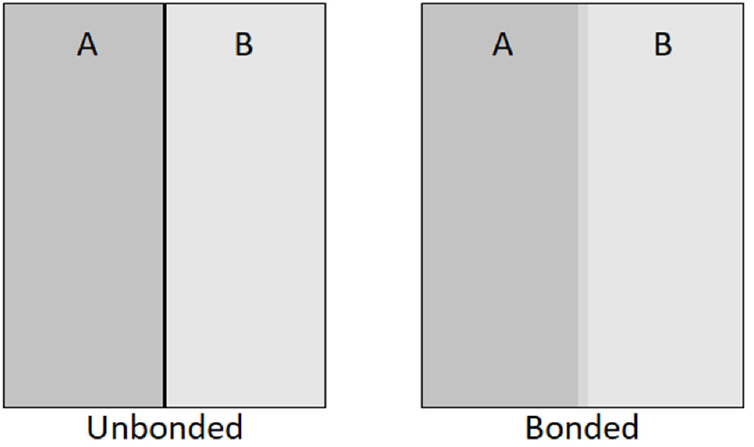
Figure 1. Scheme showing the unbonded (A/B) and bonded (A.B.) steel disc configurations. In both assembly configurations, three holes were drilled to position the thermocouples